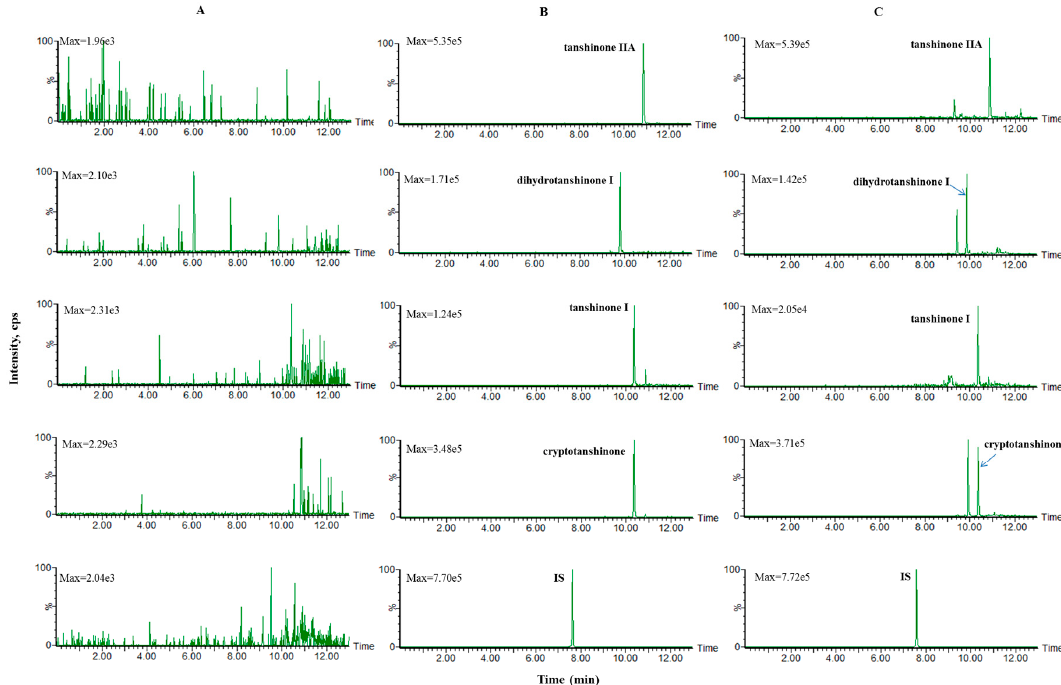
Figure 1. Representative multiple-reaction monitoring chromatograms of ( A ) blank plasma; ( B ) the blank plasma spiked with middle concentration standard solution and IS; ( C ) plasma samples at 2 h after oral administration of SMEE to rats spiked with IS.